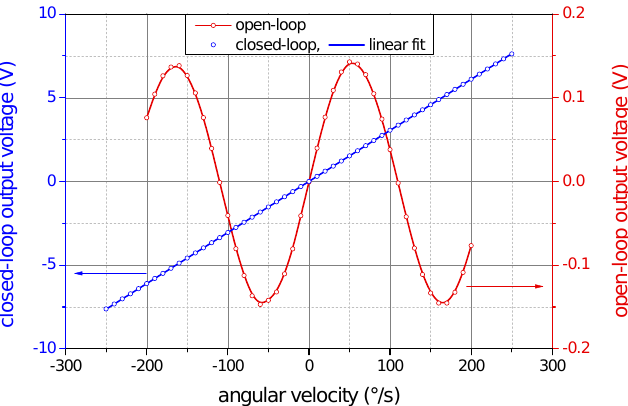
Figure 9. The output characteristics of the I-FOG measured during open-loop and closed-loop